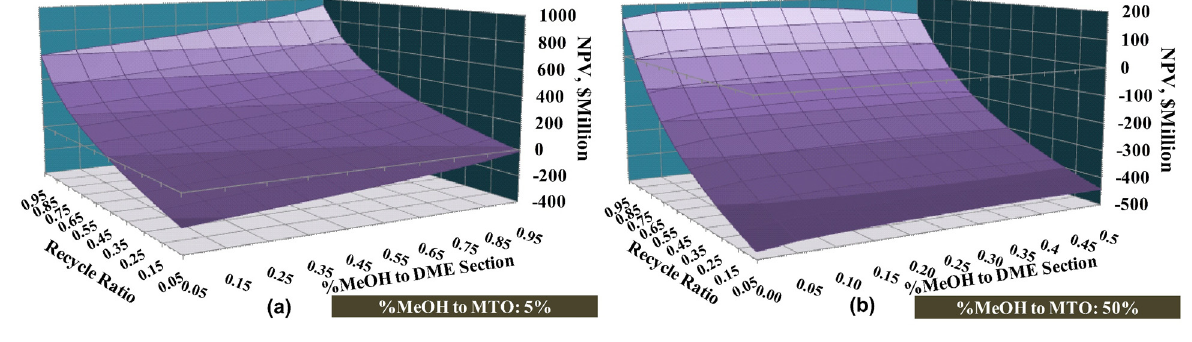
Figure 1. Effect of recycle ratio of unreacted gases to the methanol synthesis reactor and %MeOH to DME section on the NPV of plant at ( a ) low olefin (5%); ( b ) high olefin (50%) production